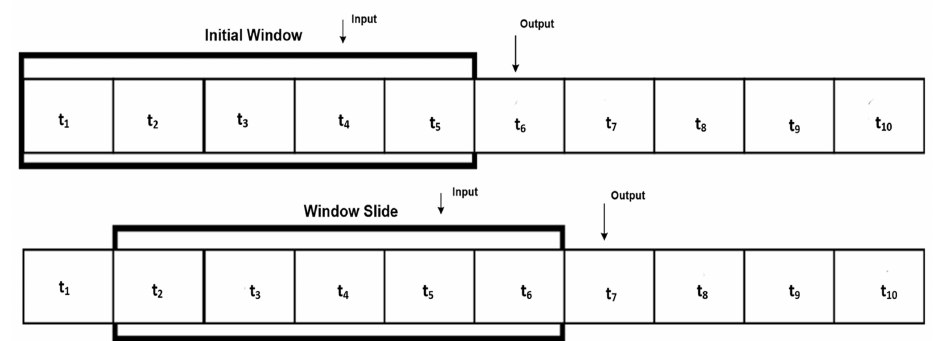
Figure 15. Summary of sliding window with one-step forecasting